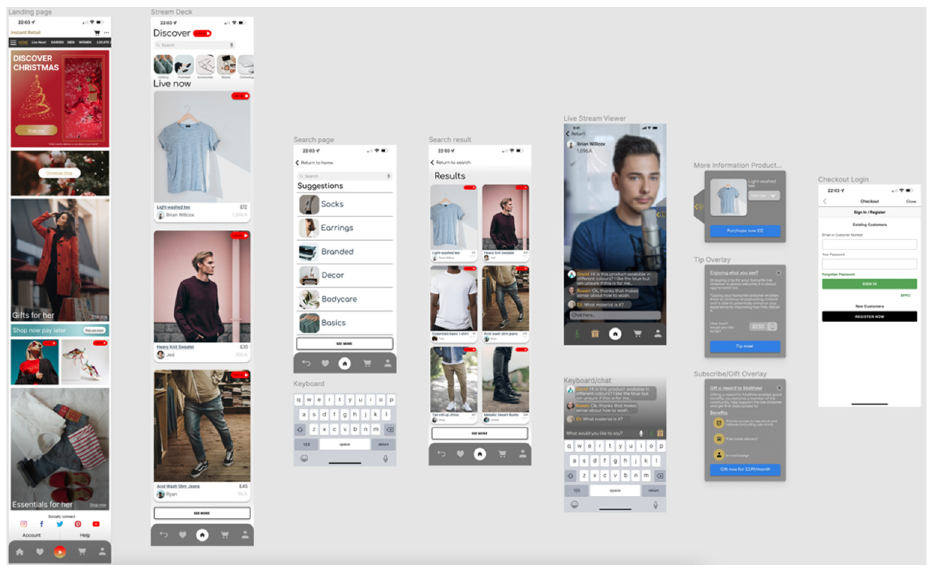
Figure 14. A screenshot from the high-fidelity mock-ups of a live stream commerce ‘plug-in’ generated from the Participatory and Co-design workshops, in Figma.